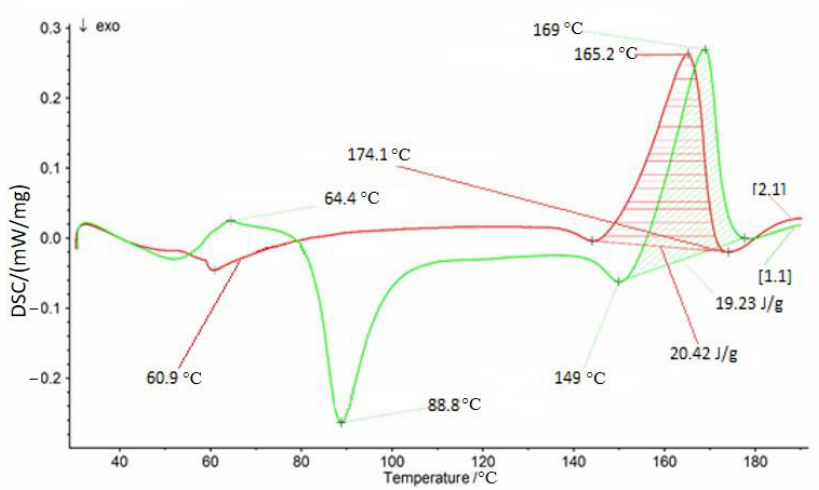
Figure 3. DSC thermal curves for pure PLA (green curve) and PLA after crystallization process (red curve).